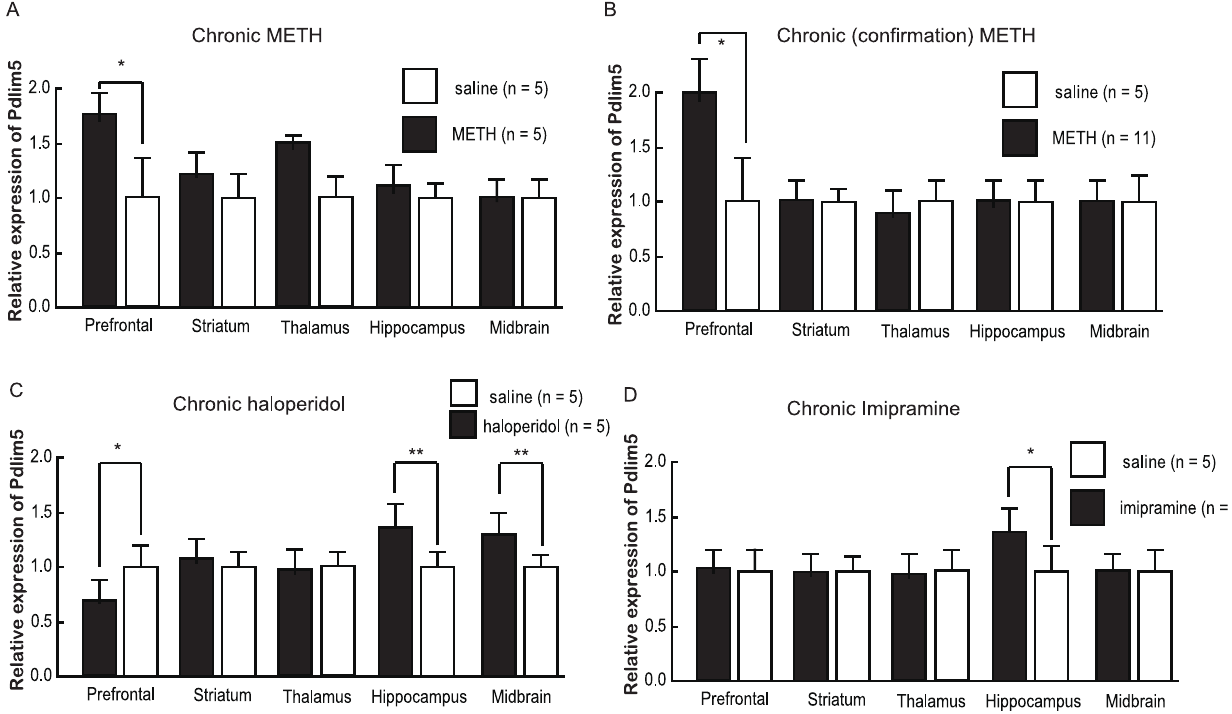
Figure 5. Relative Pdlim5 expression levels after METH, haloperidol and imipramine administrations in mice brains. Seven-week-old C57BL/6J male mice were treated with an intraperitoneal injection (i.p.) of METH (3.0 mg/kg, once daily for 14 days) (A, B), haloperidol (1 mg/kg, once daily for 49 days) (C), imipramine (20 mg/kg, once daily for 14 days) (D), or vehicle-saline. The upregulated Pdlim5 expression in the prefrontal cortex of chronic METH-administered mice (A) was confirmed by a separate experiment using a different mice cohort (B). Values are shown as mean 6 SD. * p , 0.05 and ** p , 0.01 by Student’s t test.